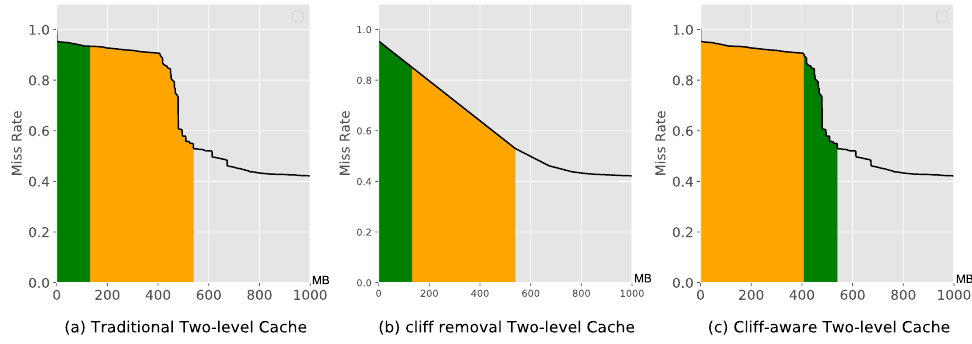
Figure 5. Comparison of three cache allocation.